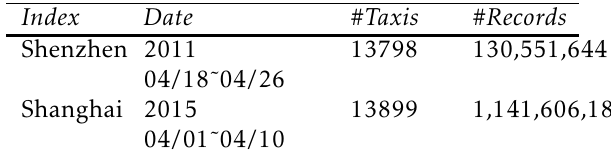
Table 1. Overview of Datasets